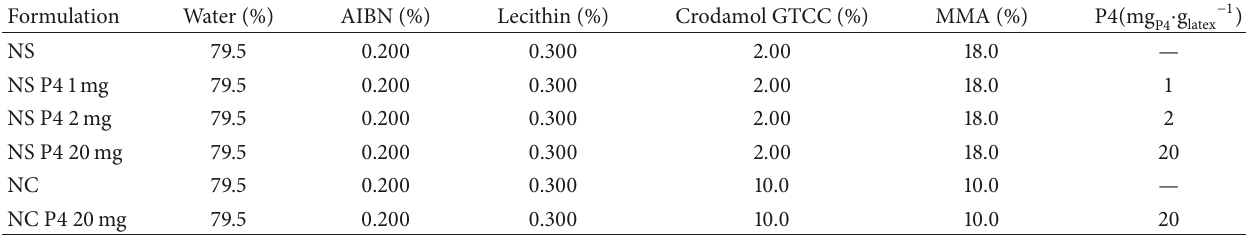
Table 1: Standard miniemulsion formulation for progesterone encapsulation in PMMA nanospheres (NS) or in PMMA nanocapsules (NC).